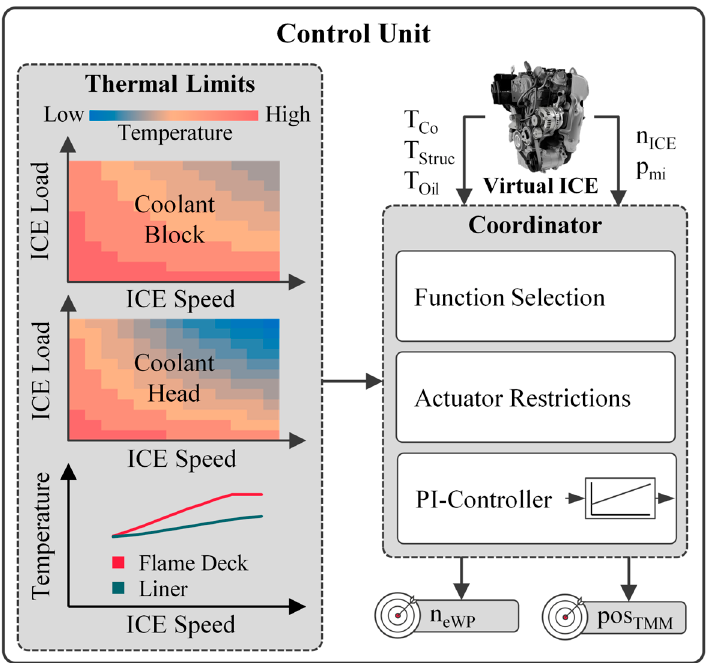
Figure 9. Schematic control structure electric actuated components in the high-temperature cooling circuit.